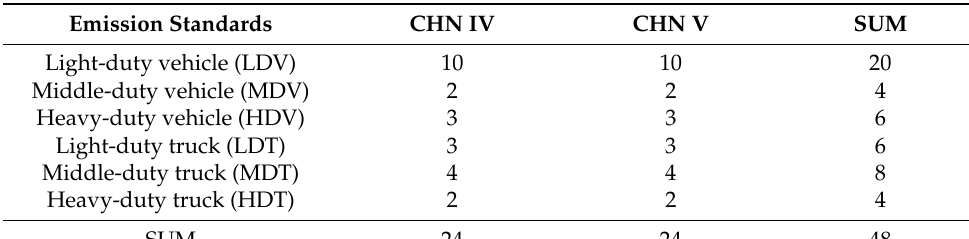
Table 3. The types of vehicles selected for on-board test.